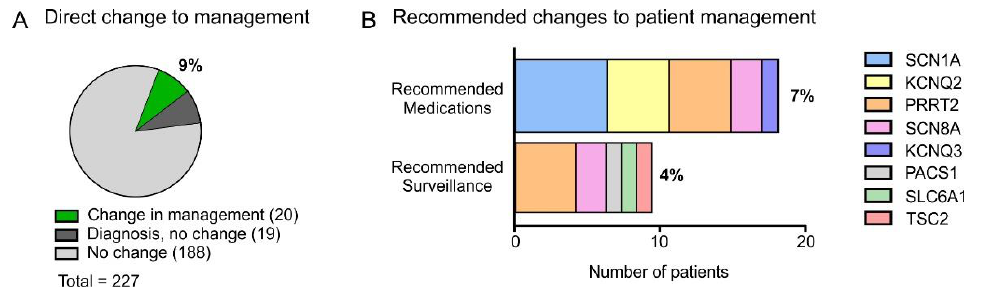
Figure 3. Changes in management. ( A ) Percentage of all patients tested for whom genetic diagnosis resulted in a change in medical management (9%). Green and grey sections combined represent the patients that received a genetic diagnosis from panel testing (17%) with the green portion showing that approximately half of those diagnosed had changes in management. ( B ) The genetic mutations associated with recommendations for changes in medical management including anti-seizure medication recommendations and surveillance or screening for co-morbidities.